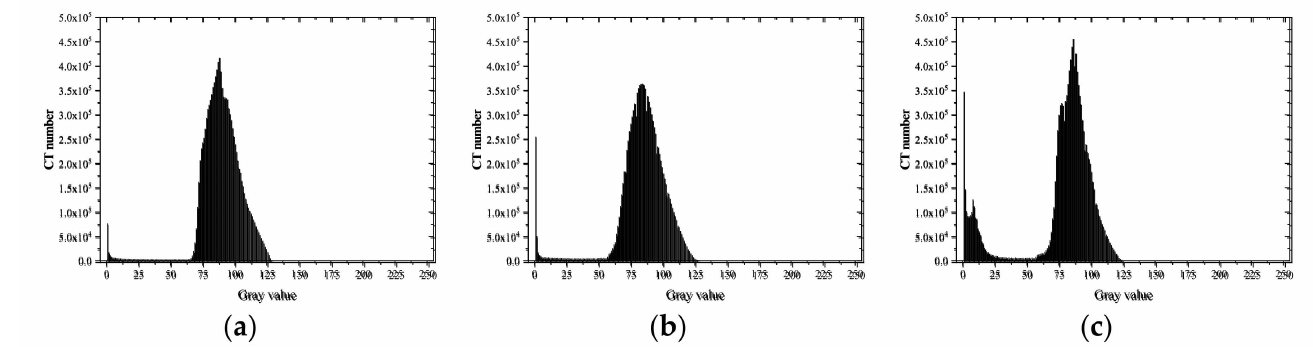
Figure 13. Gray histogram of CC: ( a ) before loading; ( b ) after loading (0.2 mm/min); ( c ) after loading (2